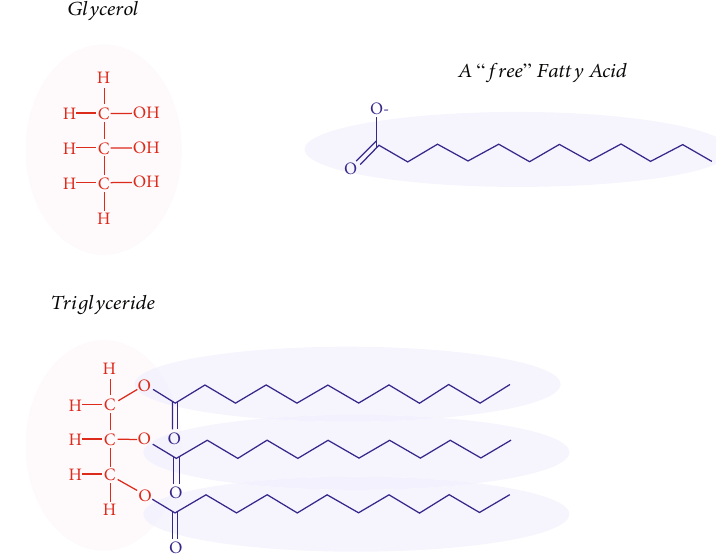
Figure 11: Olive oil triacylglycerol chemical formula